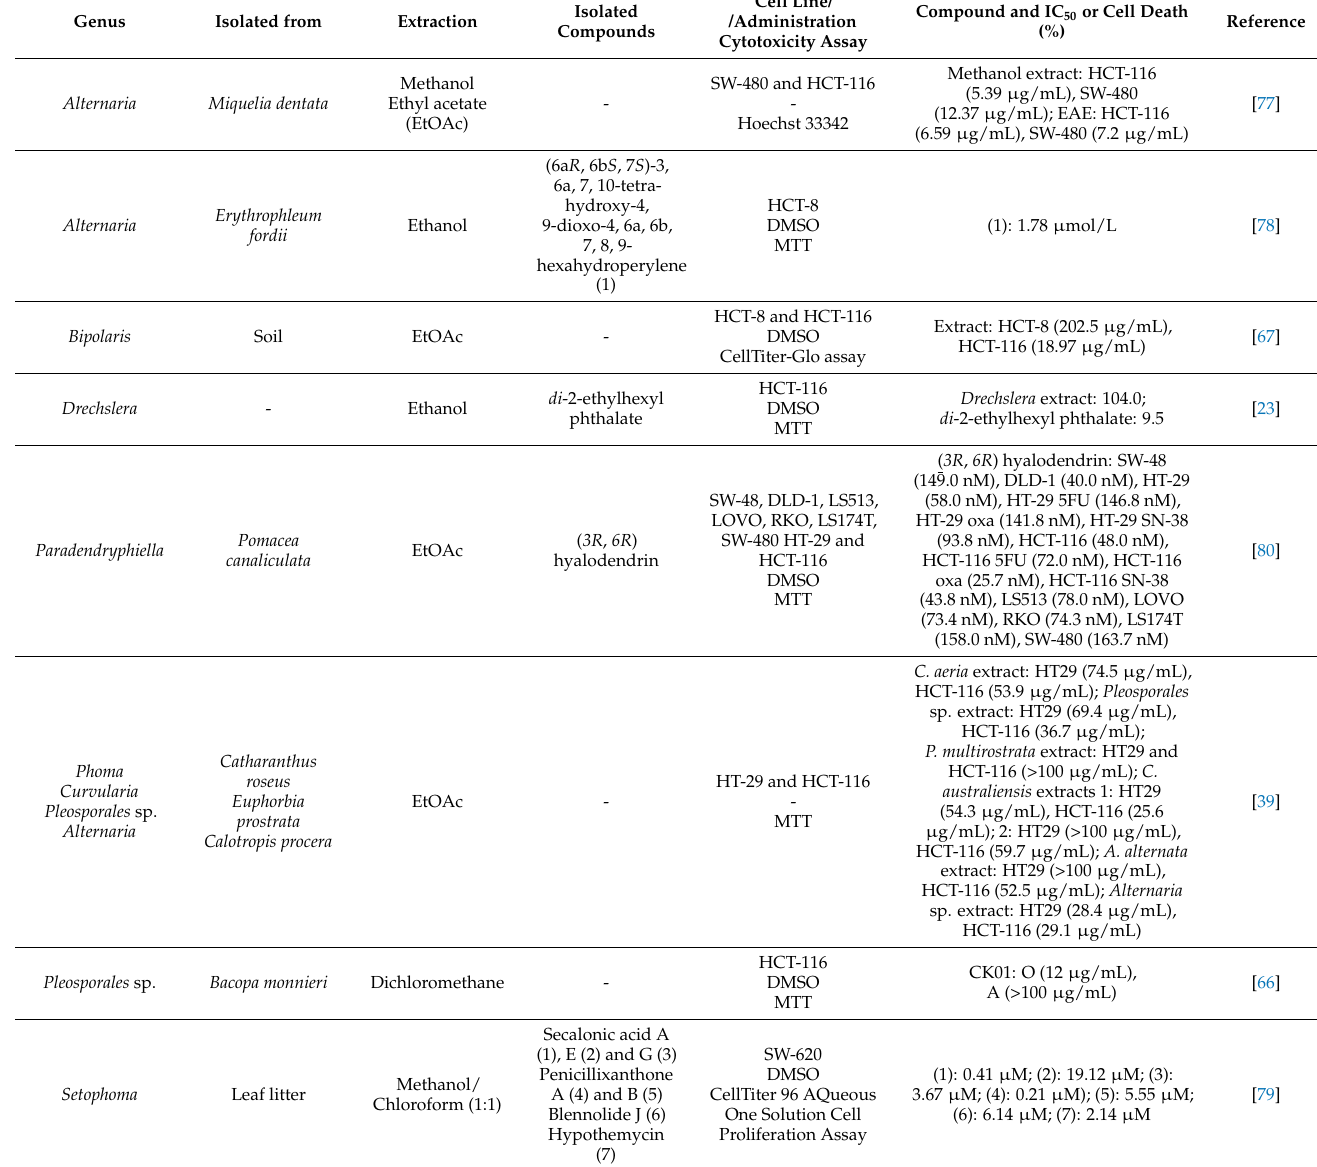
Table 3. Antitumor activity of the extracts or isolated compounds from Pleosporales order in CRC cancer cell